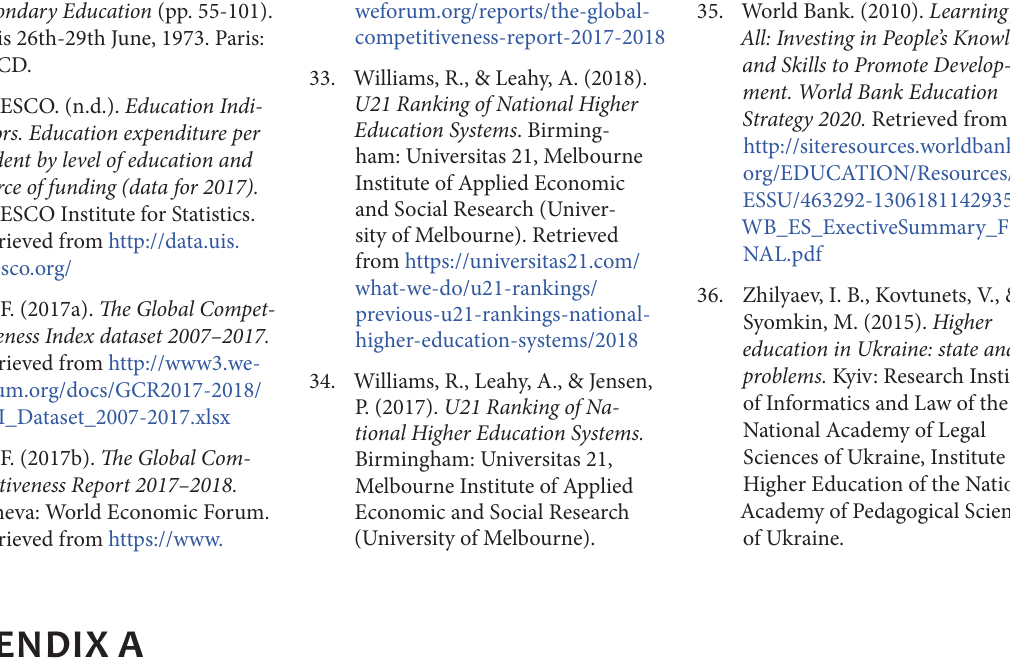
Table A1. Data used for calculations of Higher Education Systems’ Ranking and cluster analysis